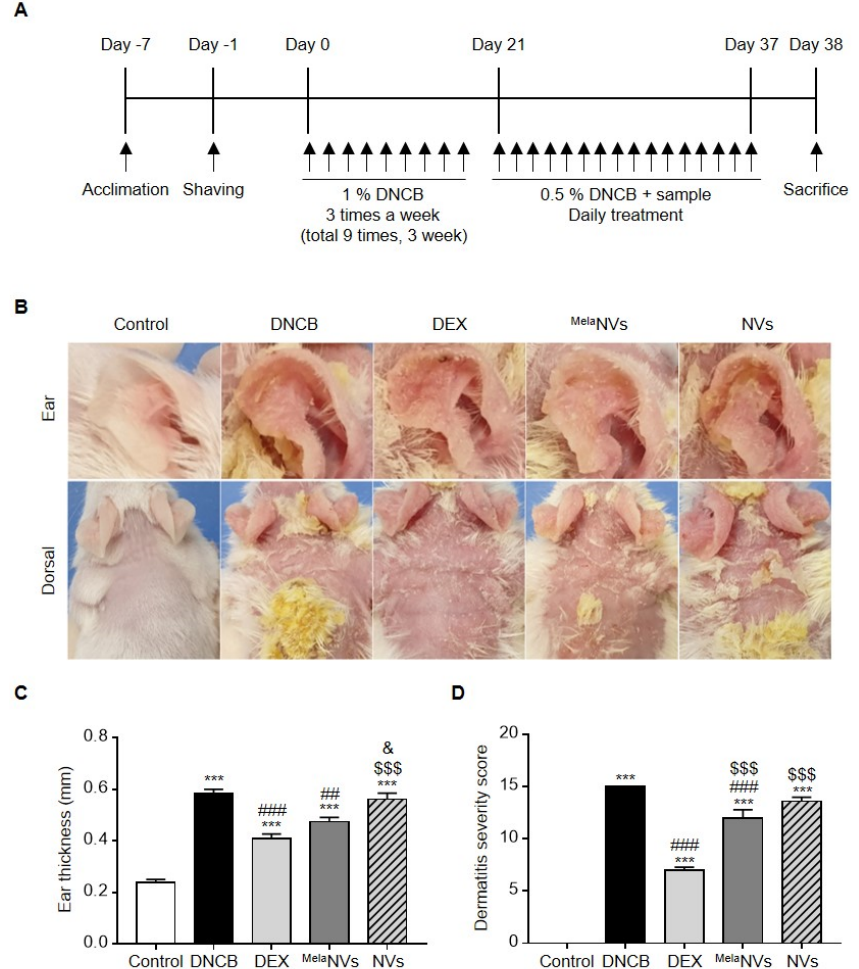
Figure 3. Mela NVs improve AD symptoms and reduce the dermatitis severity score in the DNCB-induced AD mouse model. ( A ) Schematic diagram of experimental schedule. AD-like skin lesions were induced in ears and dorsal skin of BALB/c mice with 200 μ L of 1% DNCB (administered 9 times). Mice were treated with 0.5% DNCB in the presence DEX (2.5 mg/kg), NVs (1000 μ g/mL protein), or Mela NVs (1000 μ g/mL protein, 1 mg/kg in melatonin) daily for 16 days. ( B ) Repre- sentative images of ear and dorsal skin of mice in each group on day 37. ( C ) Measure of ear thickness on day 37 ( n = 5). ( D ) Dermatitis scores (SCORAD) on day 37 ( n = 5). Data are presented as mean ± SEM. *** p < 0.001 vs. control, ## p < 0.01, ### p < 0.001 vs. DNCB group, $$$ p < 0.001 vs. DEX group, & p < 0.05 vs. Mela NVs group. H&E staining of dorsal skin showed that the application of Mela NVs effectively re- duced the epidermal thickness of the dorsal skin (Figure 4A). The measurement of the epidermal thickness further strengthened H&E results (Figure 4E). Next, we assessed mast cell infiltration in AD-like skin lesions by performing tolui- dine blue staining of the dorsal skin of mice in each group. As a result, DNCB treatment was found to considerably increase the number of mast cells in the AD-like skin lesions. Treatment with Mela NVs effectively suppressed the infiltration of mast cells into the dorsal skin, while the NV treatment did not show a significant decrease in mast cell infiltration (Figure 4B,F). Next, we evaluated the protective effects of Mela NVs against fibrosis in AD-